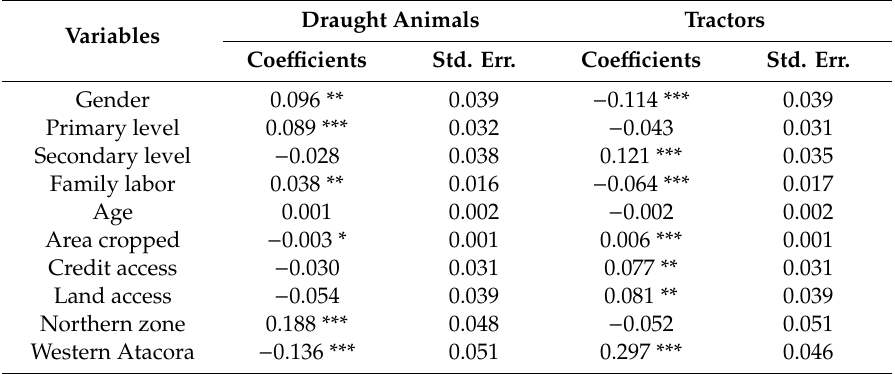
Table 5. Estimation of the marginal e ff ects of the farm mechanization